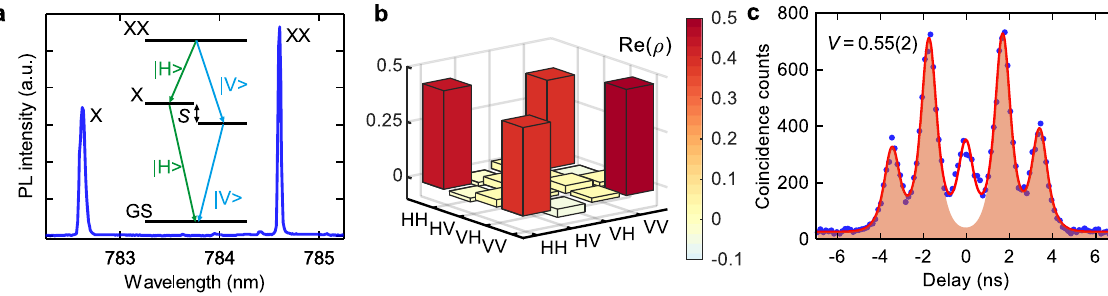
Fig. 1 Main properties of the investigated QD. a Photoluminescence spectrum of the investigated QD under resonant two-photon excitation of the XX state. In the central inset, the radiative cascade process is sketched with its energy diagram. b Real part of the experimental density matrix which describes the polarization state generated via the XX-X cascade in the rectilinear basis. c Intensity correlation histogram (blue dots) recorded in a HOM experiment on X photons with a relative emission delay of 1.8 ns. The data are fi tted with the sum of fi ve Gaussian functions convoluted to an exponential decay (red line), sharing the same FWHM. The fi tted area of the side peaks is highlighted. The estimated interference visibility is also reported.